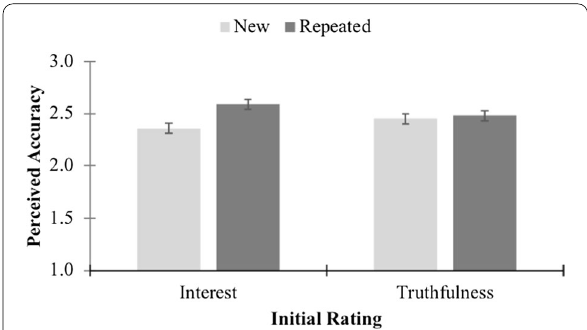
Fig. 3 Differences between perceived accuracy of new and repeated headlines for both initial rating conditions in Experiment 2 (error bars show 95%